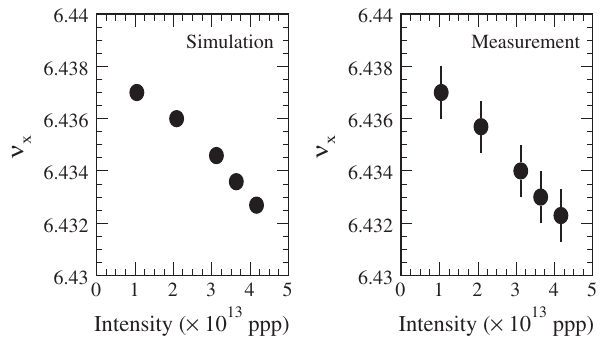
FIG. 13. Simulated (left) and measured (right) results of beam intensity versus tune ν x , obtained from FFTs of turn-by-turn beam positions for 1000 turns at the middle of the acceleration cycle of 10